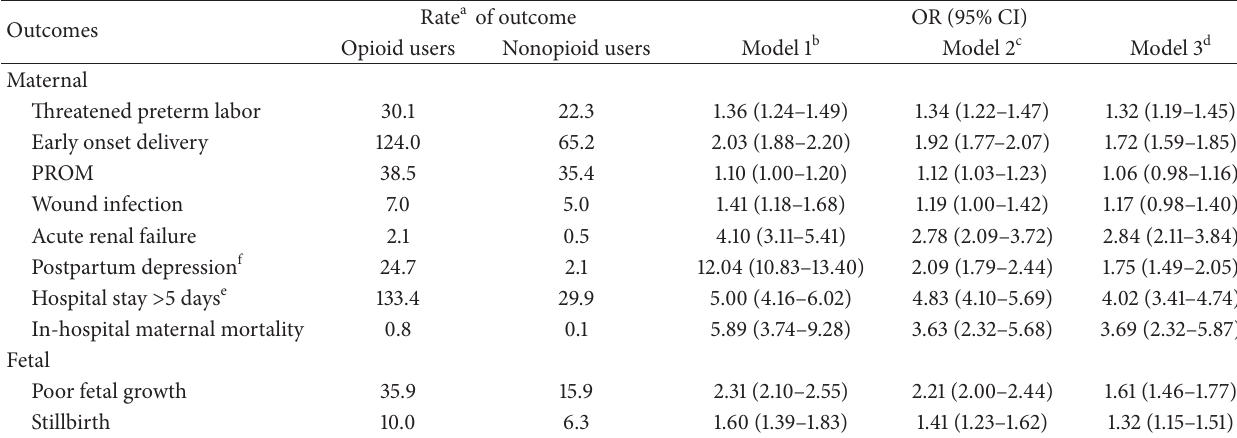
Table 2: Rates a of selected clinical outcomes by opioid use status and odds ratios and 95% confidence intervals for the association between opioid use and each outcome among pregnancy-related discharges, NIS,